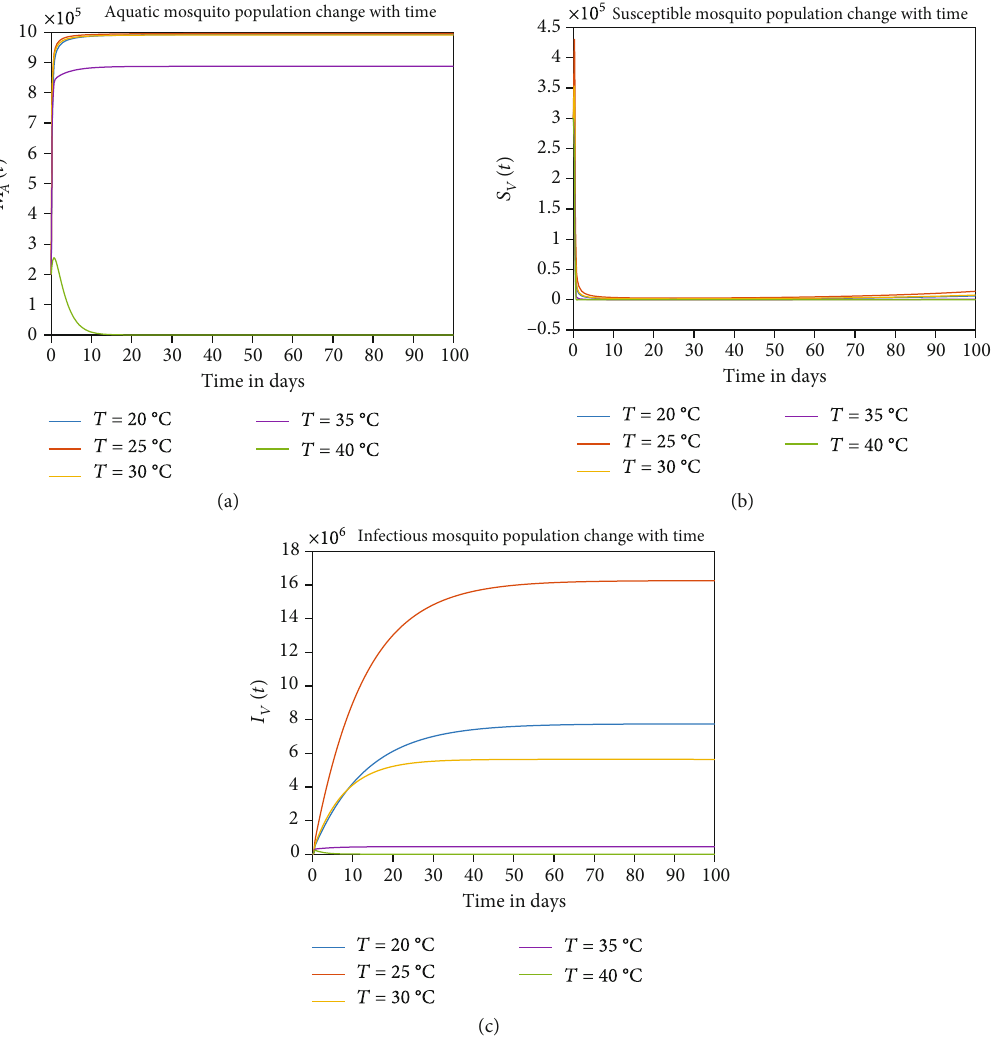
Figure 4: Change in the mosquito population over time for temperatures values T = 20 ° C , T = 25 ° C , T = 30 ° C , T = 35 ° C , and T = 40 ° C . (a) The number of aquatic mosquitoes over a period of 100 days. (b) The number of susceptible mosquitoes over a period of 100 days. (c) The number of infectious mosquitoes over a period of 100